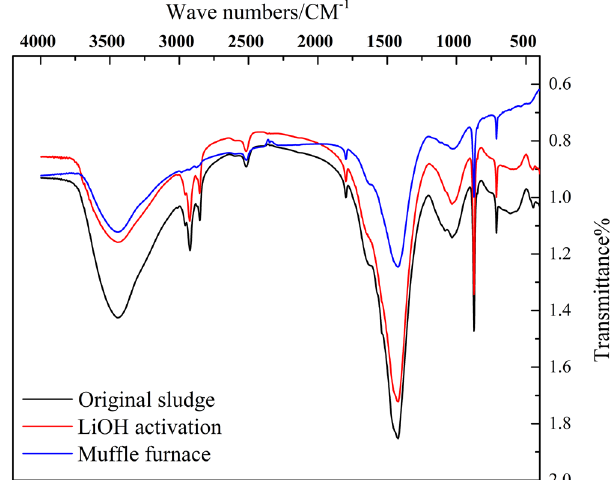
Figure 7. Infrared spectrogram of different catalysts.